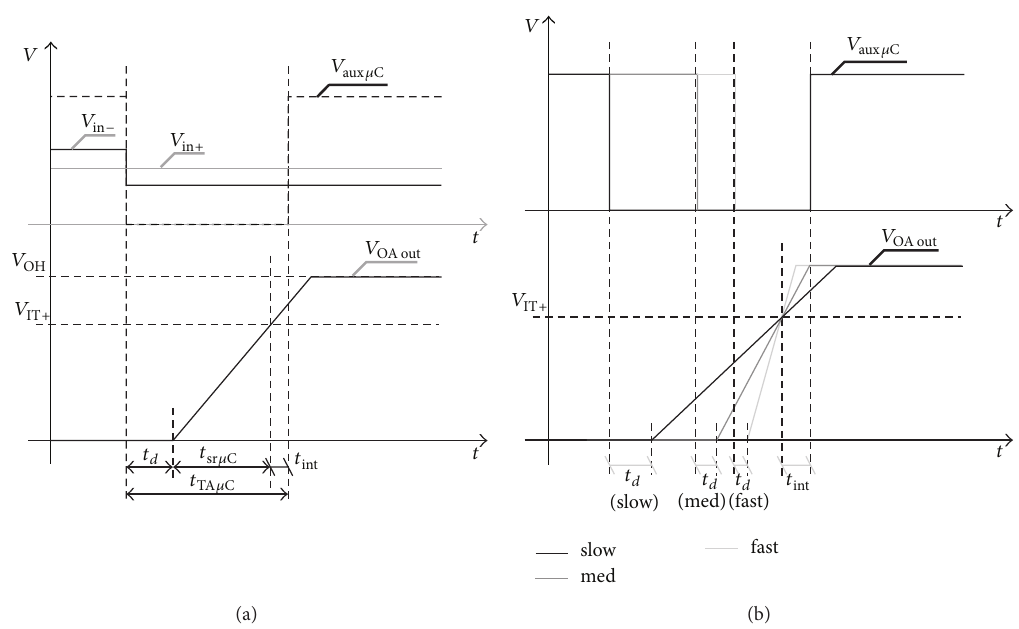
Figure 12: (a) Slewrate test timing diagram. (b) Experimental measurement of 𝑡 𝑑 , 𝑡 int , and 𝑉